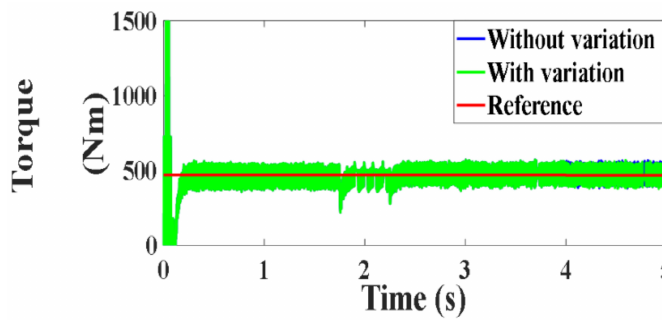
Figure 69. Developed torque under PVC (Nm).